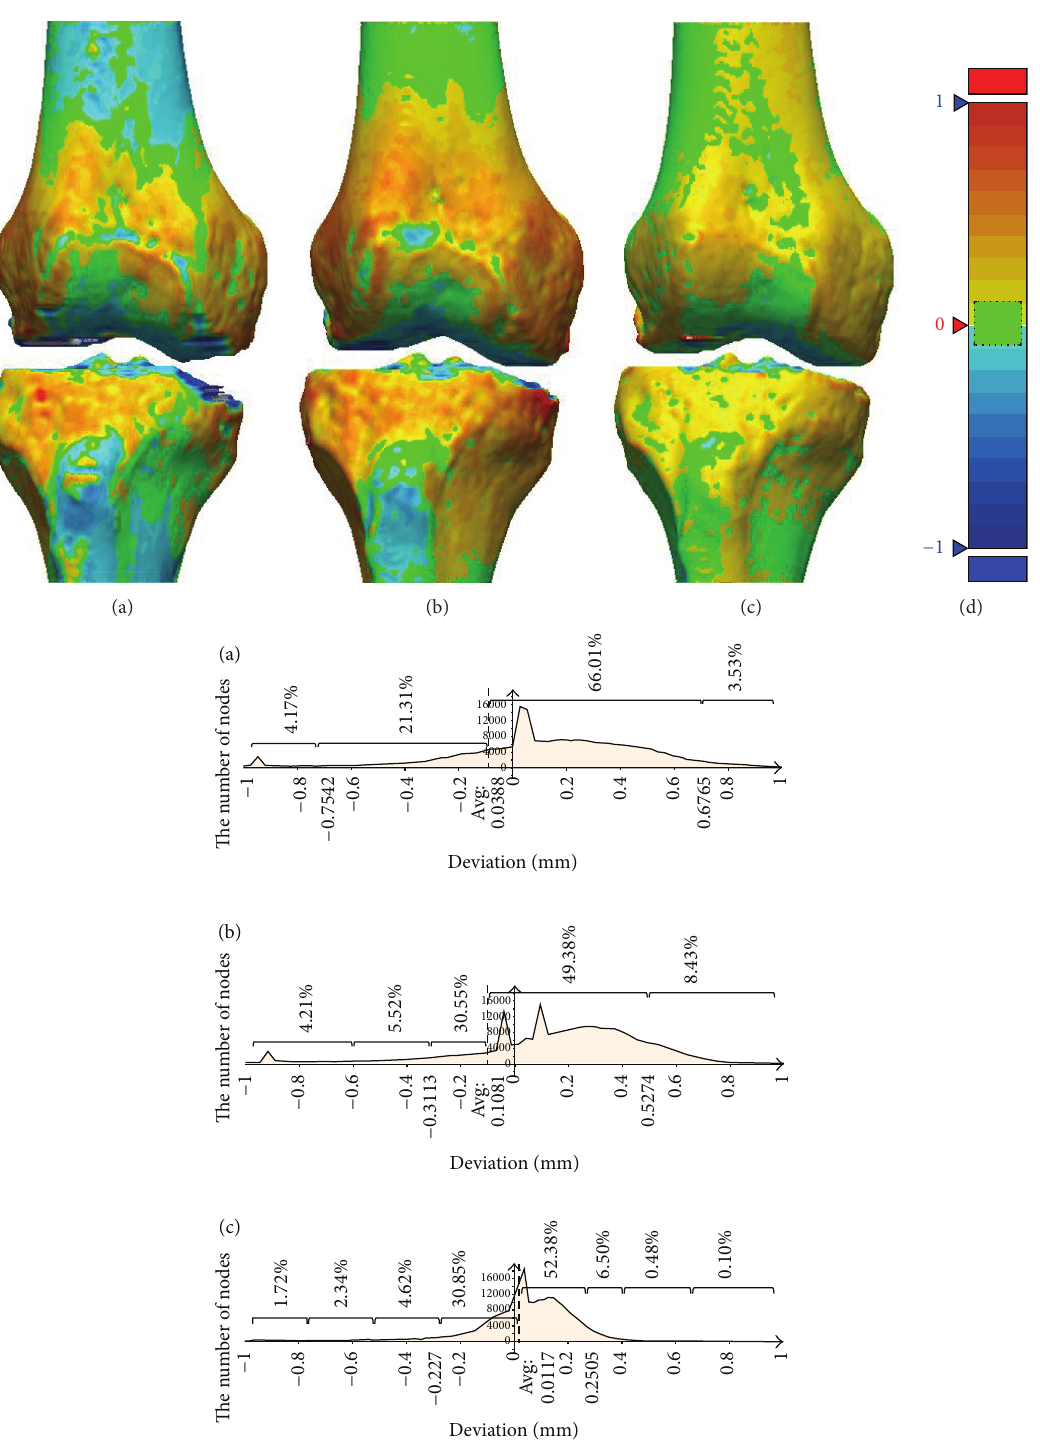
Figure 9: Morphological comparison on two bones. (a) Shape comparisons for Methods 1 and 2, (b) Methods 1 and 3, (c) Methods 1 and 4, (d) the spectrum of colour map, and (e) morphological deviations distribution for ((a), (b), and (c)). (Dimensions larger than those of Method 1 model are indicated by the color red; smaller dimensions are represented by blue. When the models are similar and the morphological deviation approaches 0mm, they are described as